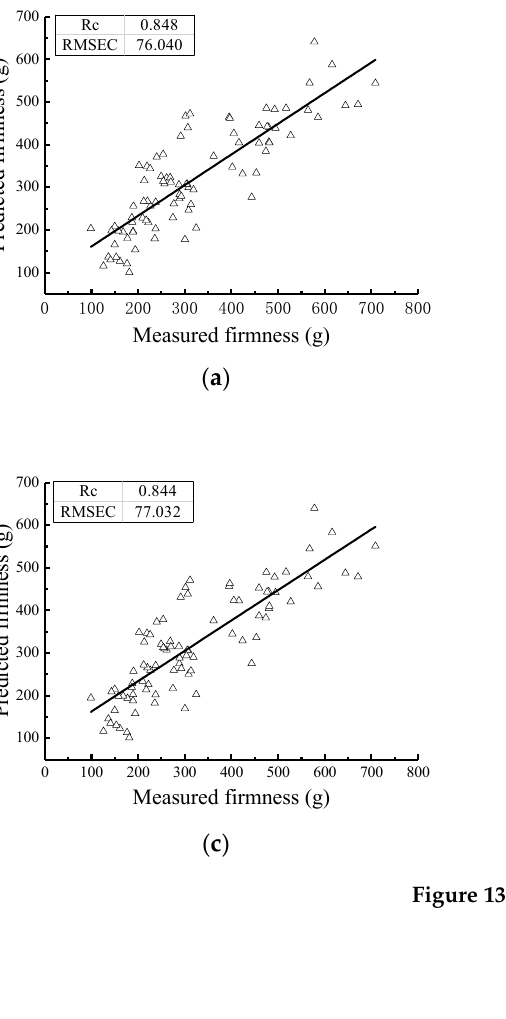
Figure 12. Scatter plot of the distribution of the firmness values of the Nanguo pears.